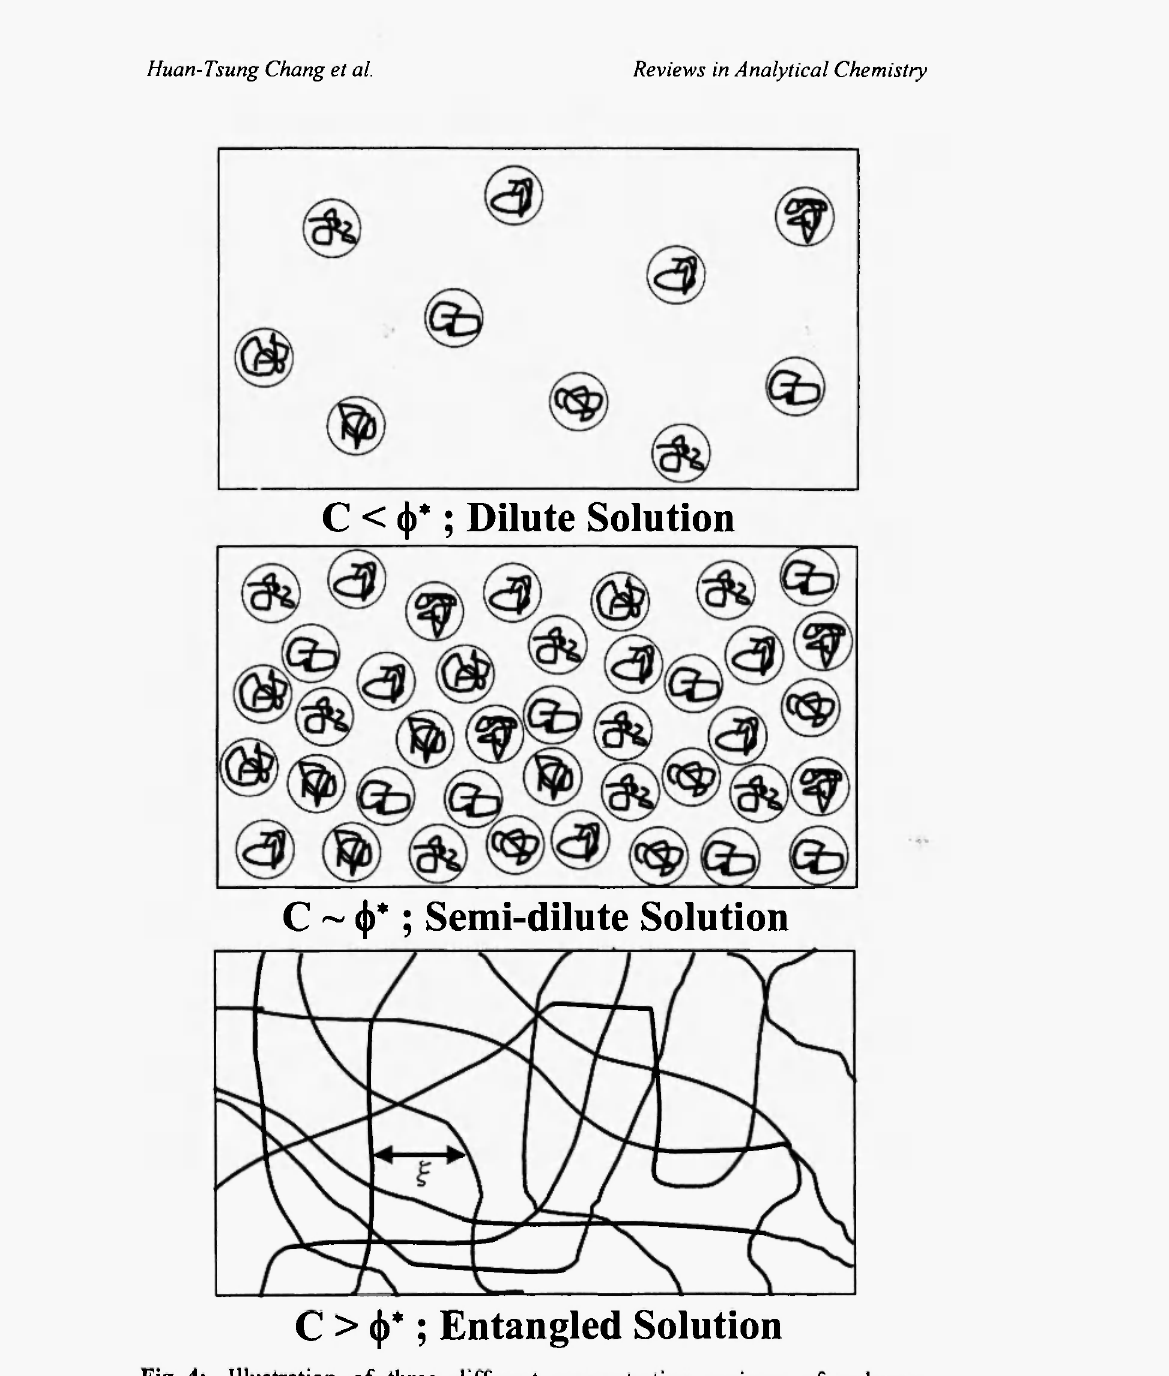
Fig. 4: Illustration of three different concentration regimes of polymer